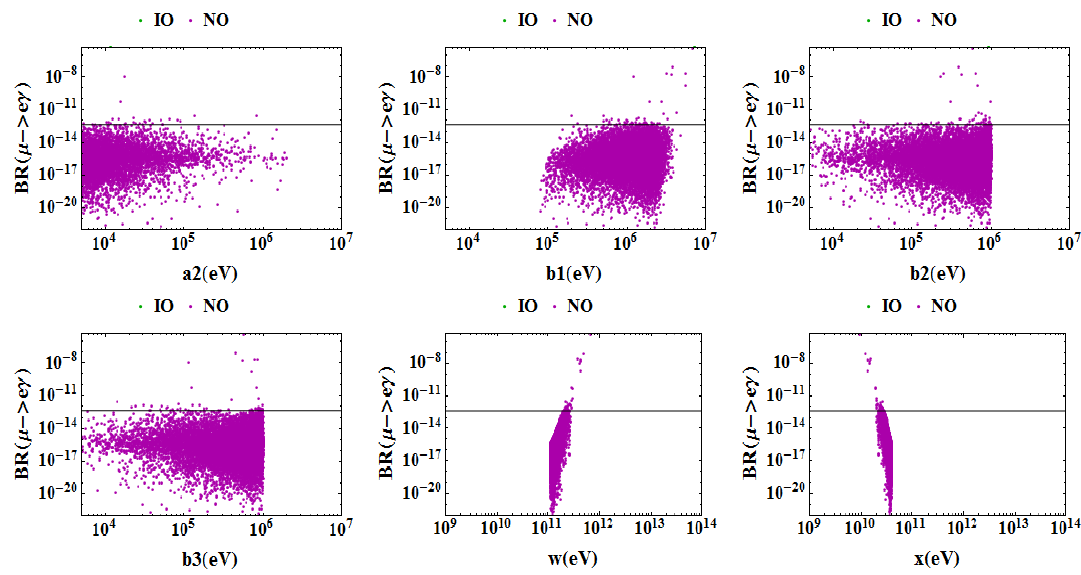
JHEP06(2019)064